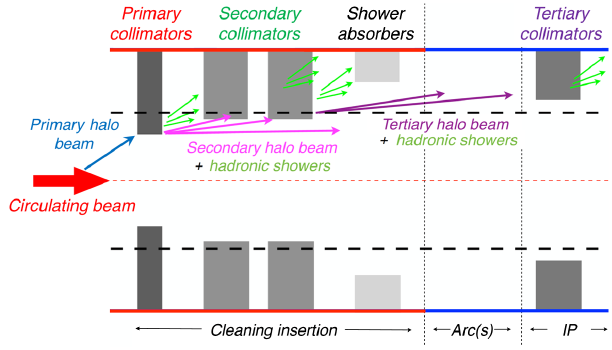
FIG. 3. Scheme of the collimator hierarchy in the